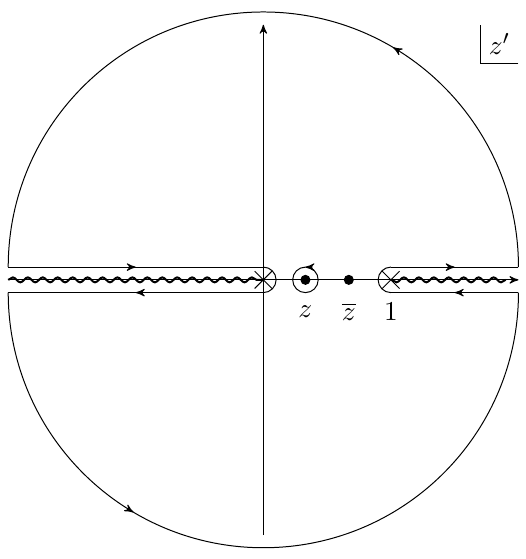
Figure 2 . Contour deformation determining the dispersion